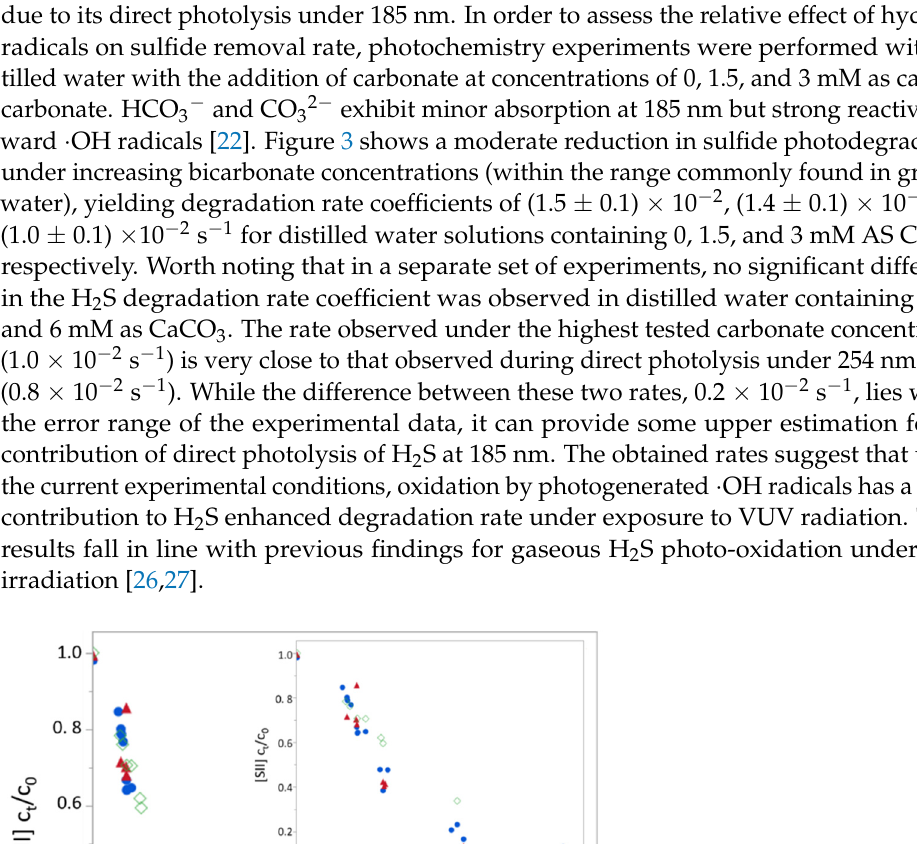
Table 1. Chemical and physical characterization of two natural groundwater sources from the Arava Valley (Israel).